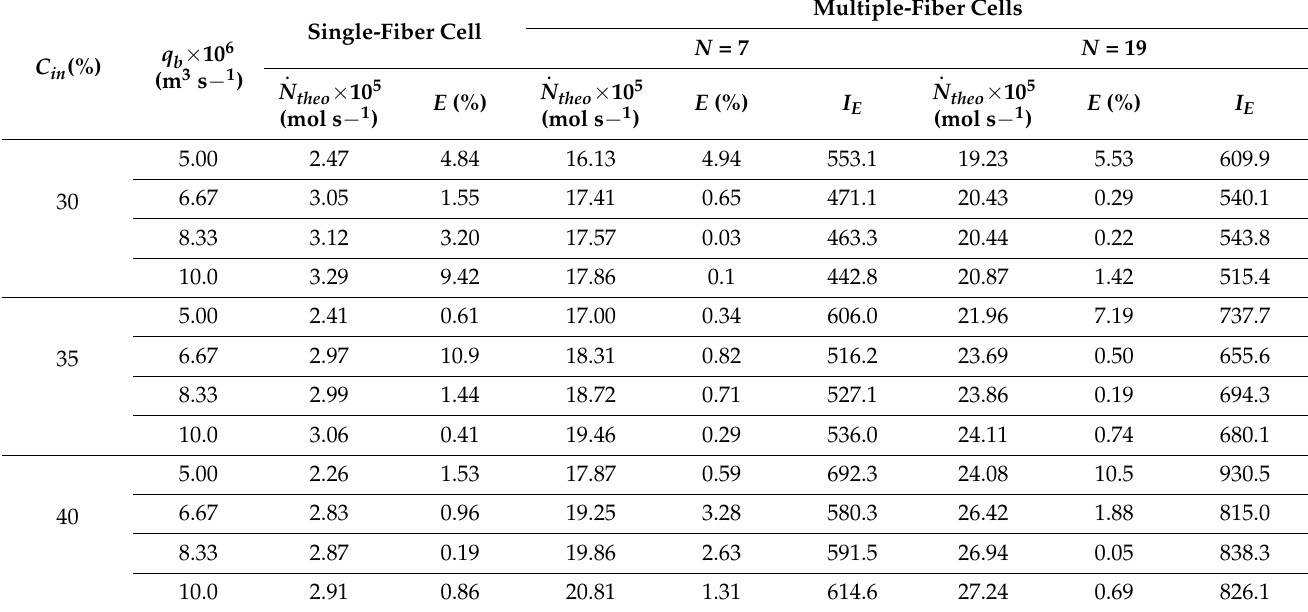
Table 1. Effects of MEA flow rate and various fiber cells on I E for cocurrent-flow operations.